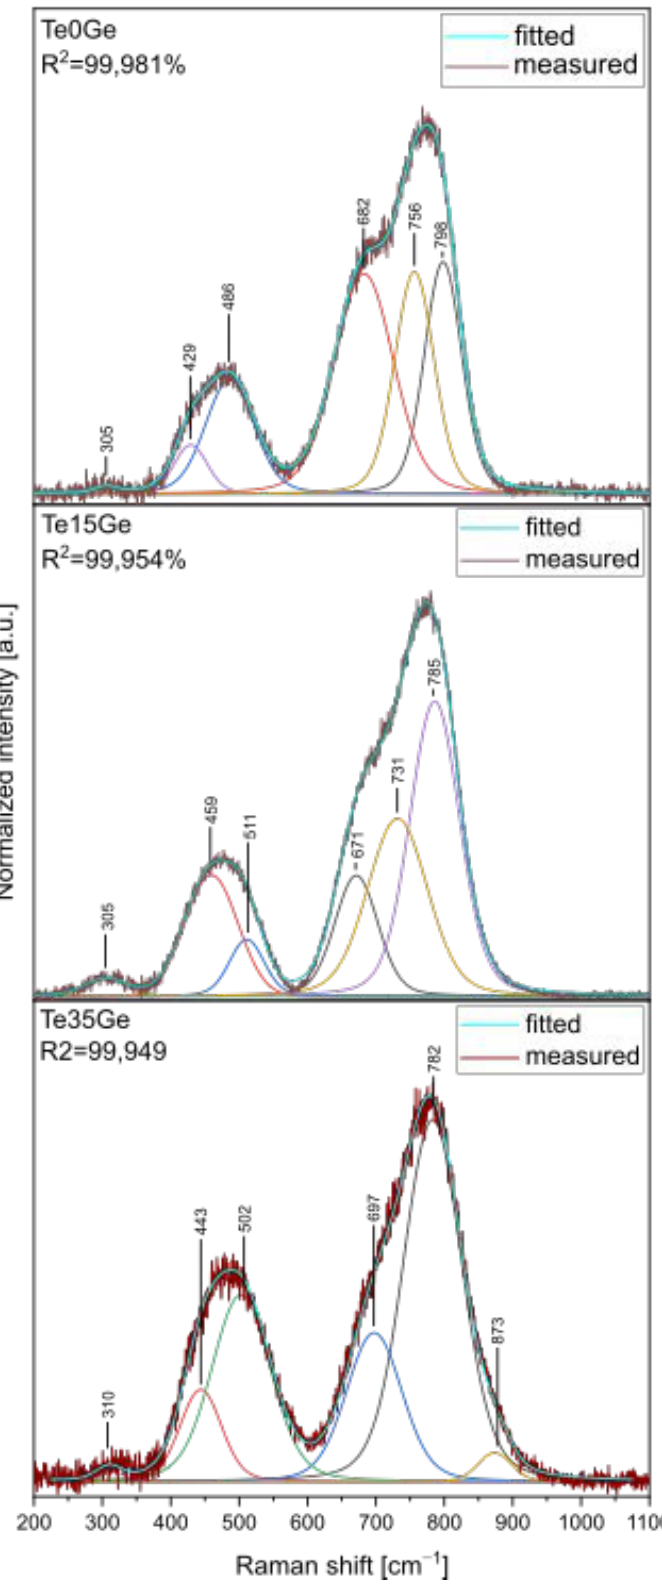
Figure 7. Raman spectra decomposition of the Te0Ge, Te15Ge, and Te35Ge glasses doped with Eu 3+